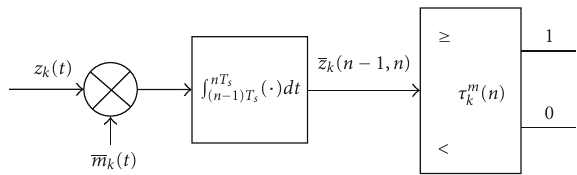
masses in the pdf of L k ( z k ( t ; n − 1, n )), the optimal decision